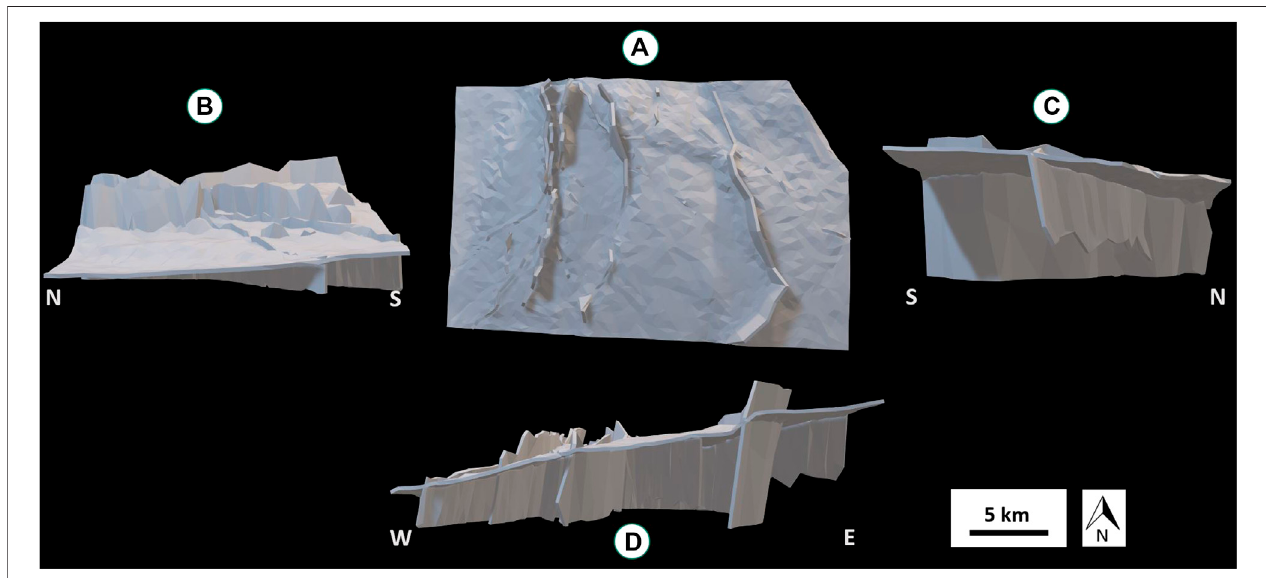
FIGURE 3 | 3D printing model. (A) Plan view location of fault orientations. (B – D) Side view of the 3D model.